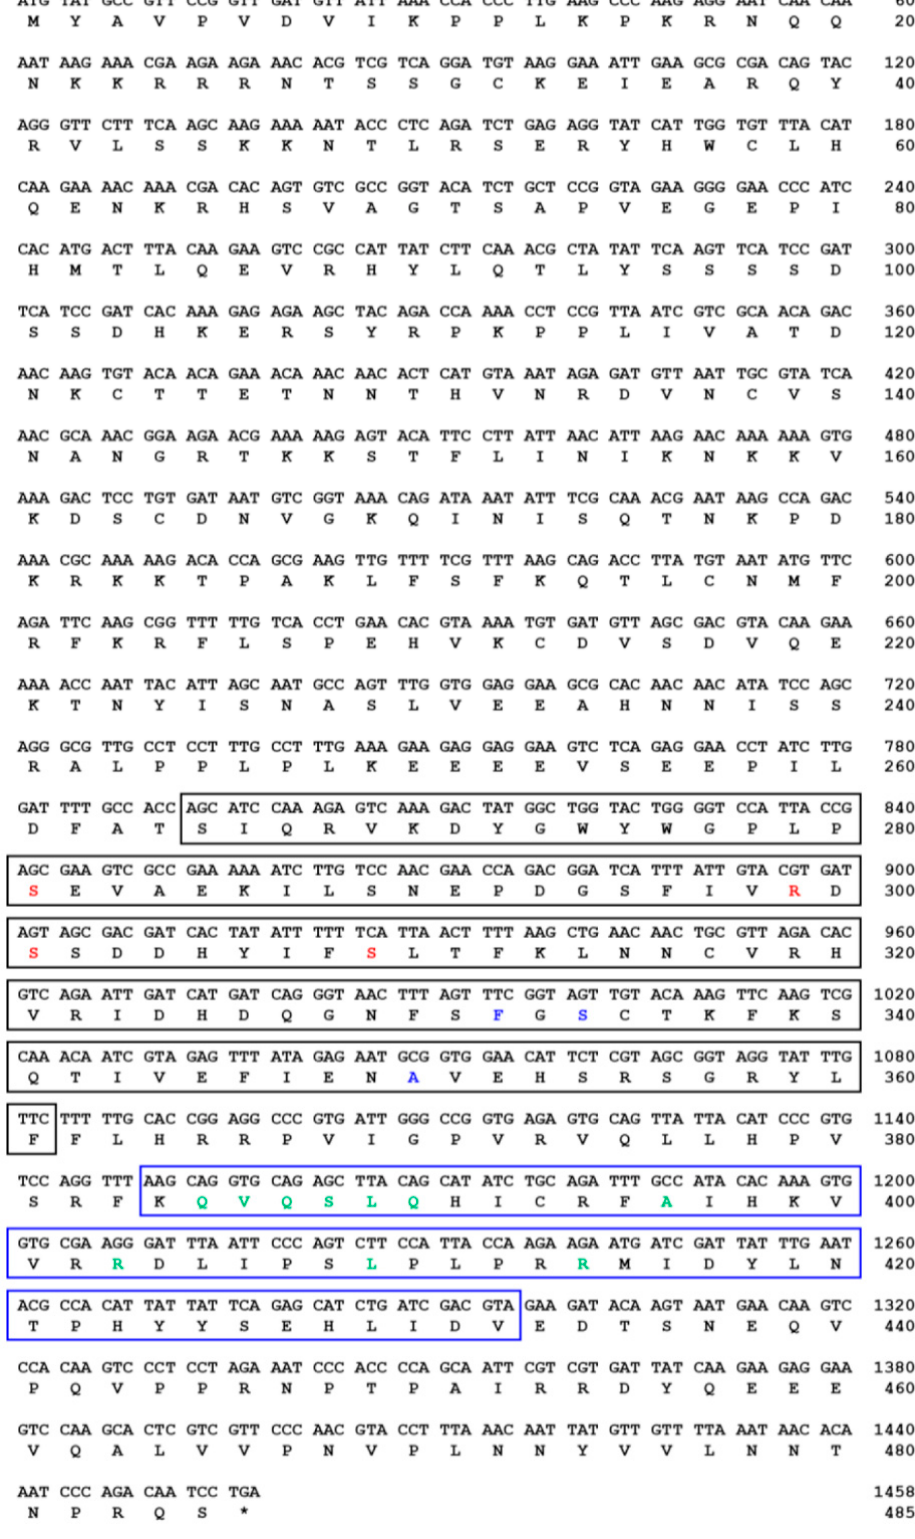
Figure 3. The nucleotide and deduced amino acid sequence of T. molitor SOCS7 (TmSOCS7). The conserved SH2 and SOCS box domains are shown in black and blue boxes, respectively. The phosphotyrosine binding pocket, hydrophobic binding pocket, and putative elongin B/C interaction residues are highlighted in red, blue, and green text, respectively.